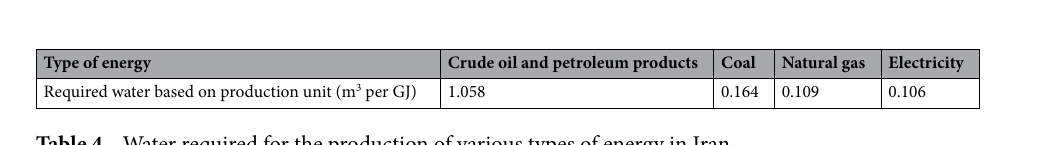
Table 4. Water required for the production of various types of energy in Iran.